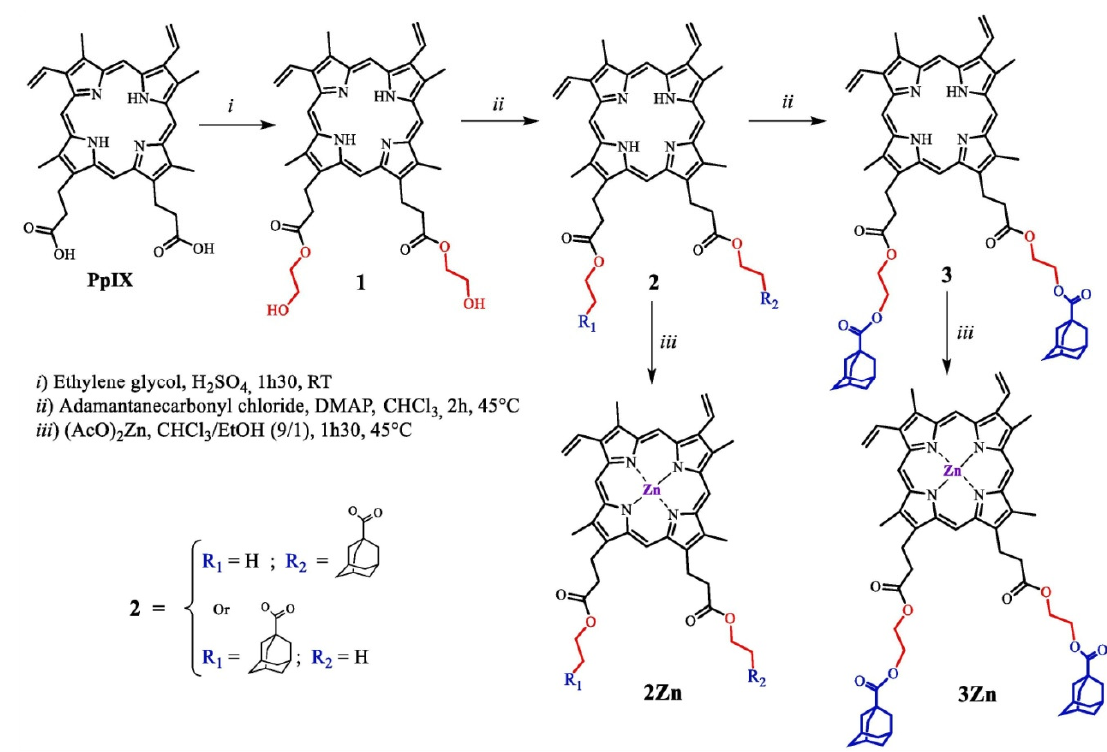
Figure 11. Synthesis of adamantane–PpIX derivatives 2Zn and 3Zn [92]. CNCs were obtained from cellulose microfibrils (hydrophilic cotton) after sulfuric acid hydrolysis. After dialysis, their chemical structure showed the presence of some anionic groups (sulfate group) at the C-6 position of some glucose units. Therefore, they could bind cationic cyclodextrin (CD) by ionic interaction. Subsequently, due to the affinity of the hydrophobic cavity of CD for nonpolar molecules, the CD–CNC ionic complexes could be loaded with mono- or di–adamantane–zinc–PpIX(2Zn–CD/CNC and 3Zn–CD/CNC) (Figure 12). In vitro experiments were performed to test the efficiency of the synthesized complexes and the importance of vectorization via CNC. In vitro phototoxicity of 2Zn and 3Zn compounds, as well as 2Zn–CD/CNC and 3Zn–CD/CNC complexes, was evaluated against the HT-29 cell line using the MTT method with the concentrations of PS ranging from 0.25 to 2.5 μ M during 48 h. In the dark, there was no significant cytotoxicity for all PSs, while under illumination the cytotoxicity of PSs was much stronger, especially the encapsulated ones, such that 3Zn–CD/CNC was the most active complex with IC 50 = 0.42 ± 0.02 µ M. In addition, a flow cytometry analysis was performed to study the effect of the vectorization. The fluorescence of the Zn-PpIX derivatives analyzed via flow cytometry coupled with the AMNIS ® image analysis showed that the 2Zn–CD/CNC and 3Zn–CD/CNC complexes were much more internalized than 2Zn and 3Zn. Therefore, Ndong Ntoutoume et al.’s success in the synthesis of zinc PpIX-adamantane/CD/CNC complexes with good anticancer activity against HT-29 cancer cell line awakens the possibility of using these complexes (CD/CNC) as nanocarriers in various diseases [92].